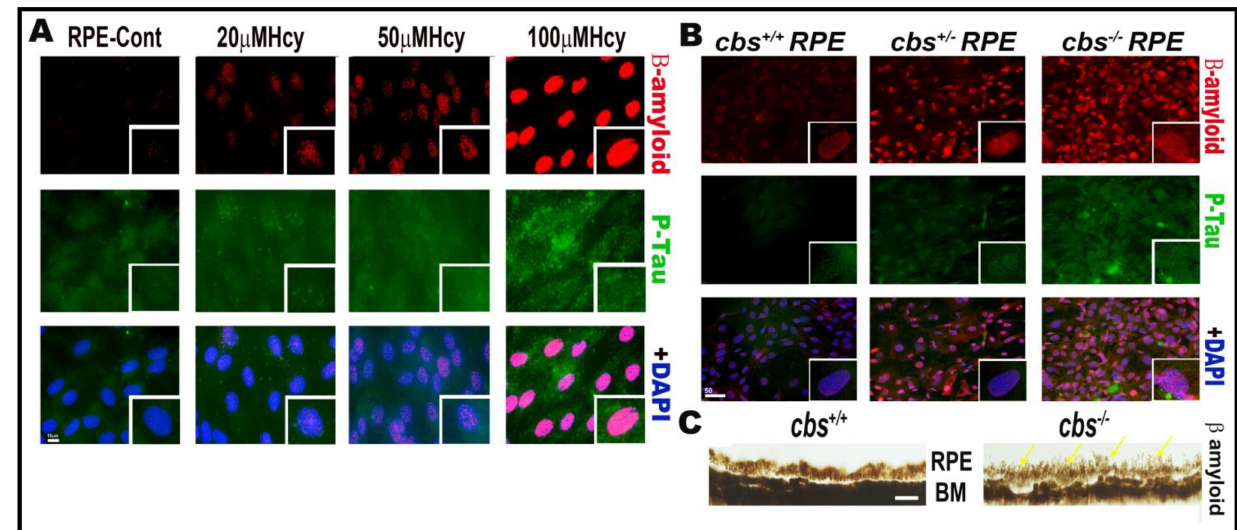
Figure 2. Hcy induces accumulation of β -amyloid and P-Tau proteins in retinal RPE. IF staining showed increased expression of β -amyloid (red) and P-Tau (green) in ( A ) RPE treated with and without Hcy (20 µ M, 50 µ M, and 100 µ M). ( B ) Primary RPE cells isolated from cbs +/ − and cbs − / − mouse retina. ( C ) Histological staining of retinal sections with thioflavin S stain showing more accumulation of β -amyloid protein in RPE area of the cbs − / − mouse retina. The cbs +/ − mice (heterozygous) represent mild/moderate HHcy, have about a 4- to 7-fold increase in plasma Hcy level, and show a mild retinal phenotype and normal life span, while the cbs − / − mice (homozygous with no copies of cbs) represent severe HHcy, have about a 30-fold increase in plasma Hcy with severe retinal phenotype and a short life span of ~3 to 5 weeks. Scale bars: 50 µ